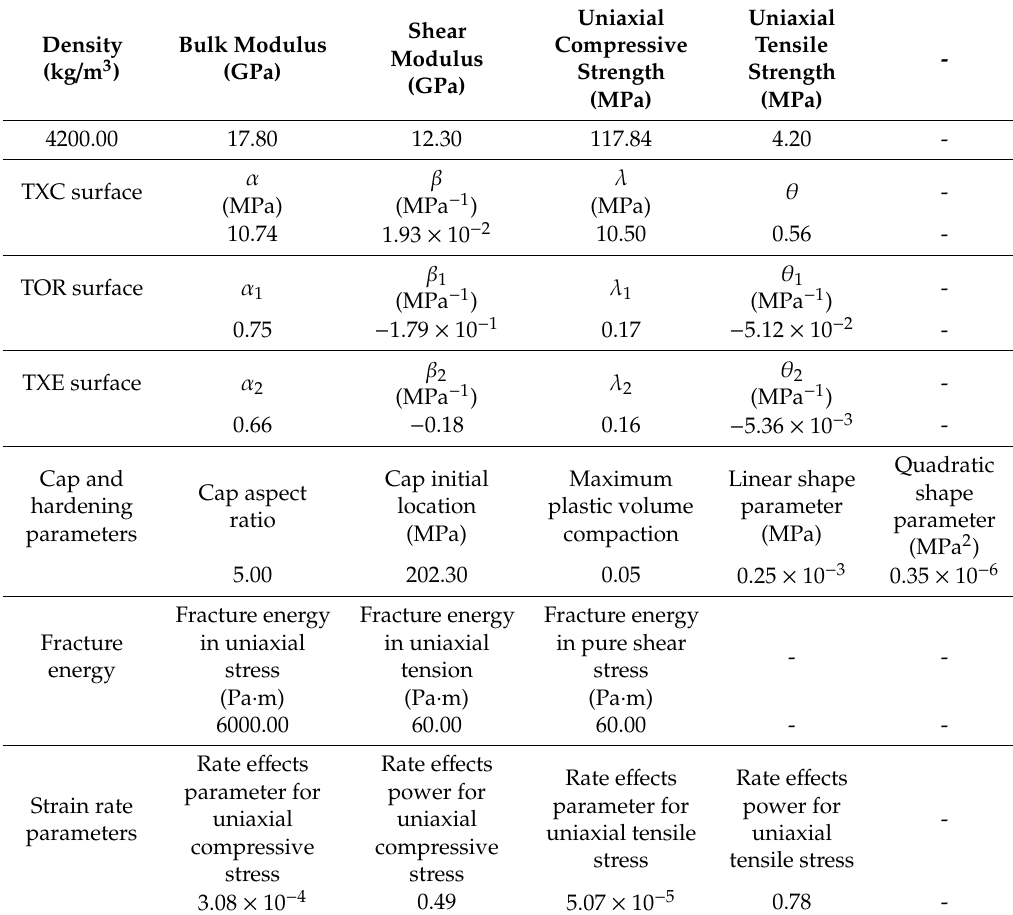
Table 1. Numerical parameters for the